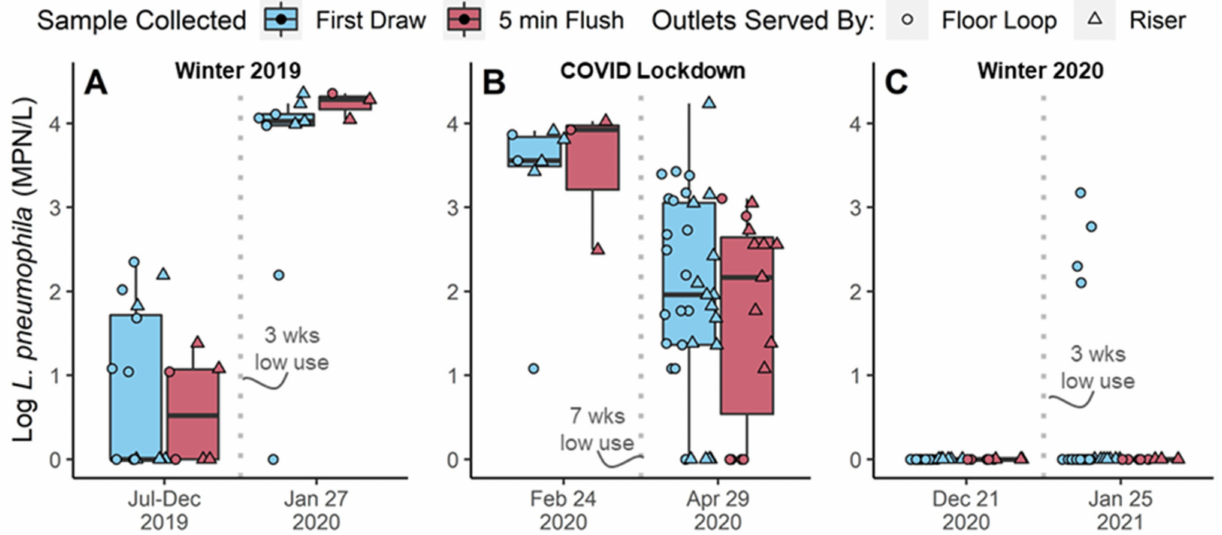
Figure 2. L. pneumophila culture numbers in hot water samples collected on a day the boiler was operated at 45 ◦ in first draw (blue) and 5-min flushed (red) samples before and after periods of low water demand due to ( A ) winter holiday break in 2019, ( B ) COVID Lockdown, and ( C ) winter holiday break in 2020. Boxplot bodies reflect the 25th, 50th, and 75th percentiles; whiskers represent 1.5 times the interquartile range. Raw data is overlaid onto the boxplots. ◦ indicates samples collected from passive floor loops (laboratory outlets); ∆ indicates samples collected from hot water risers (outlet in lavatories and